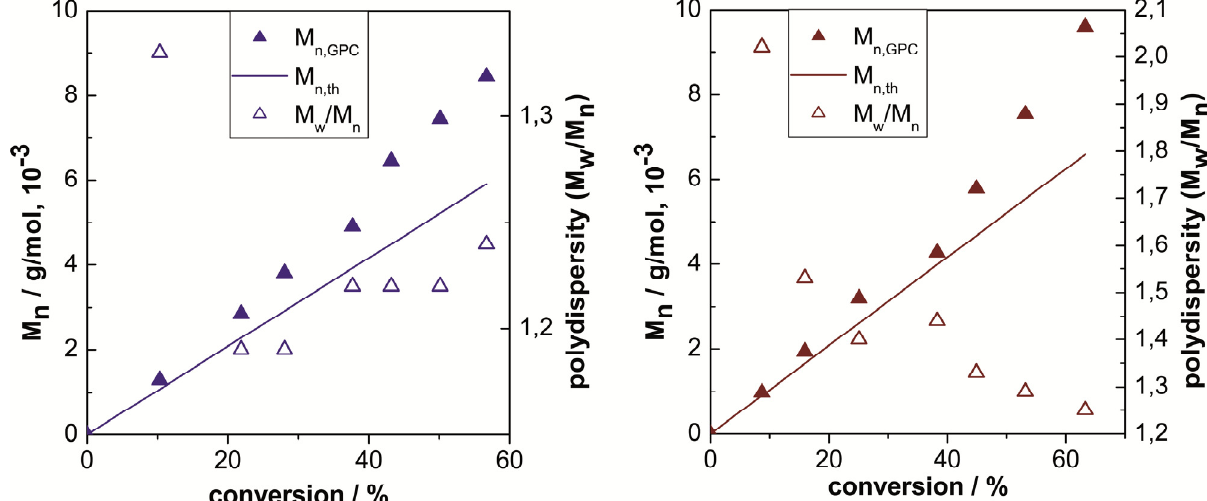
Figure 7. Progress of the number-averaged molecular weights (M molecular weight (M ) and the polydispersity with the conversion for styrene ATRP with: n,th ( left ) 2 TMGpy and CuBr; ( right ) 2 DMEGpy and CuBr; and PEBr as the initiator at 110 °C. The ratio of styrene:ligand:CuBr:PEBr =